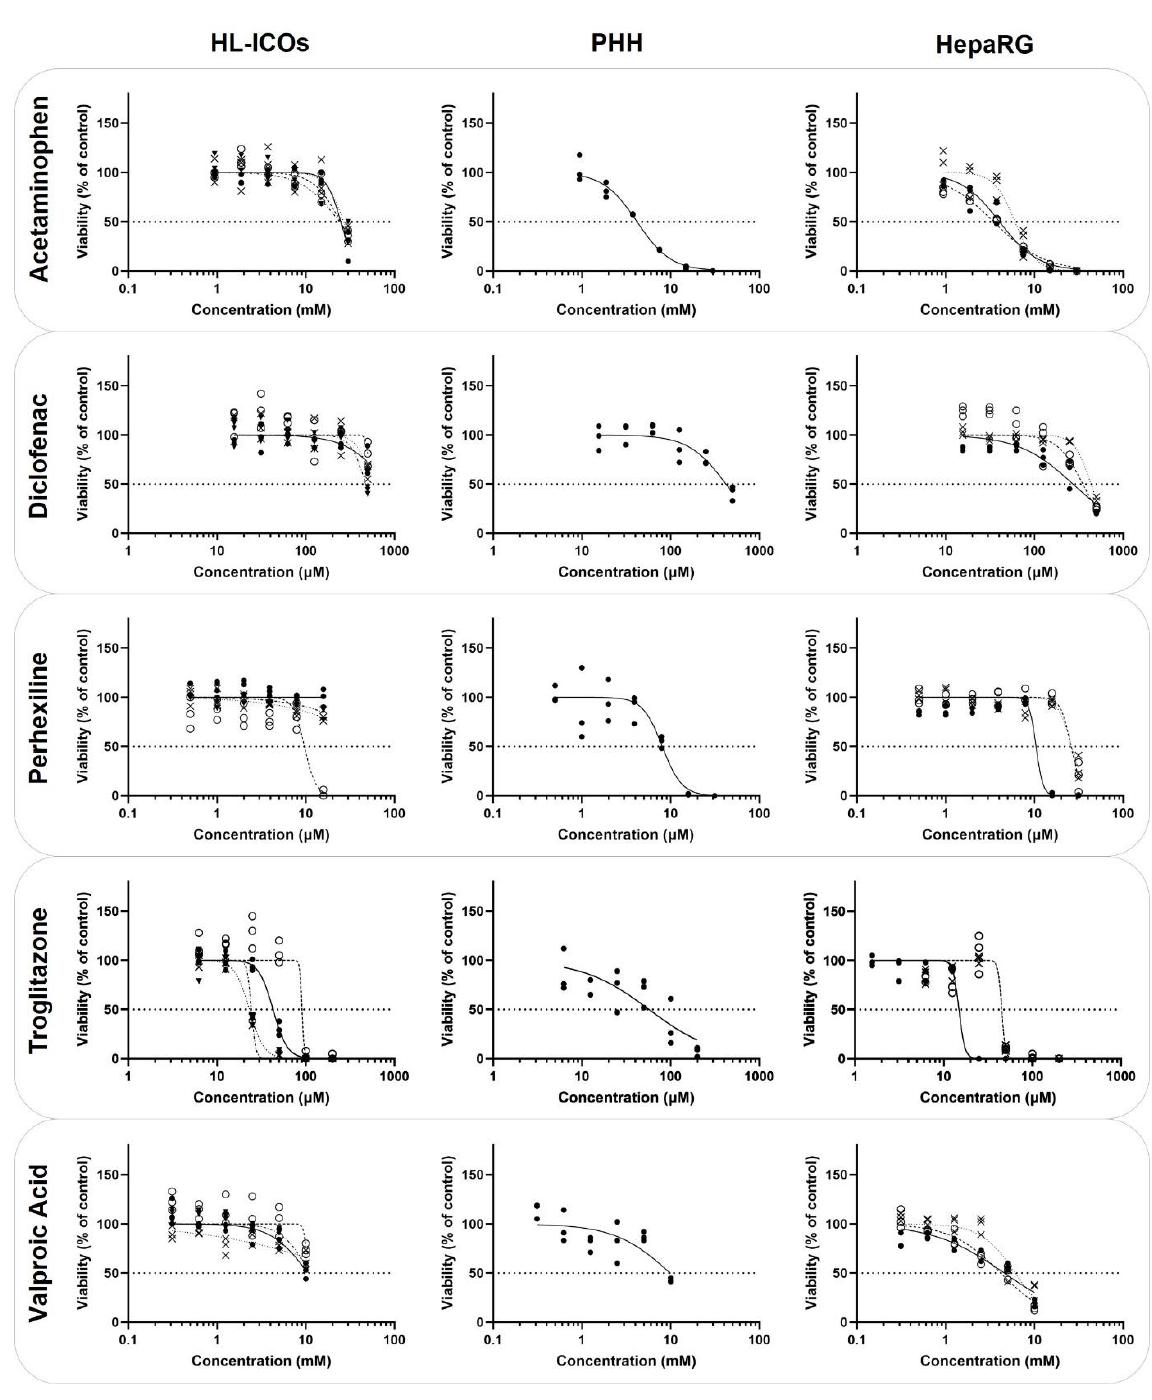
Figure 4. Sensitivity to known hepatotoxic compounds of HL-ICOs, PHHs, and HepaRGs. PHHs, HepaRG cells, and HL-ICOs (differentiation day 12) were exposed to acetaminophen, diclofenac, perhexiline, troglitazone, and valproic acid for 48 h (single dose). Data are presented as the percentage relative to the viability of (vehicle-treated) controls. For PHHs, one replicate experiment is shown. For HepaRG cells, three replicate experiments (different symbols) are shown (replicate experiments can be different between tested compounds). For HL-ICOs, four replicate experiments using different donors are shown, represented by different symbols. For all cell models, three replicate measurements per concentration are shown. Dashed line indicates 50% viability.